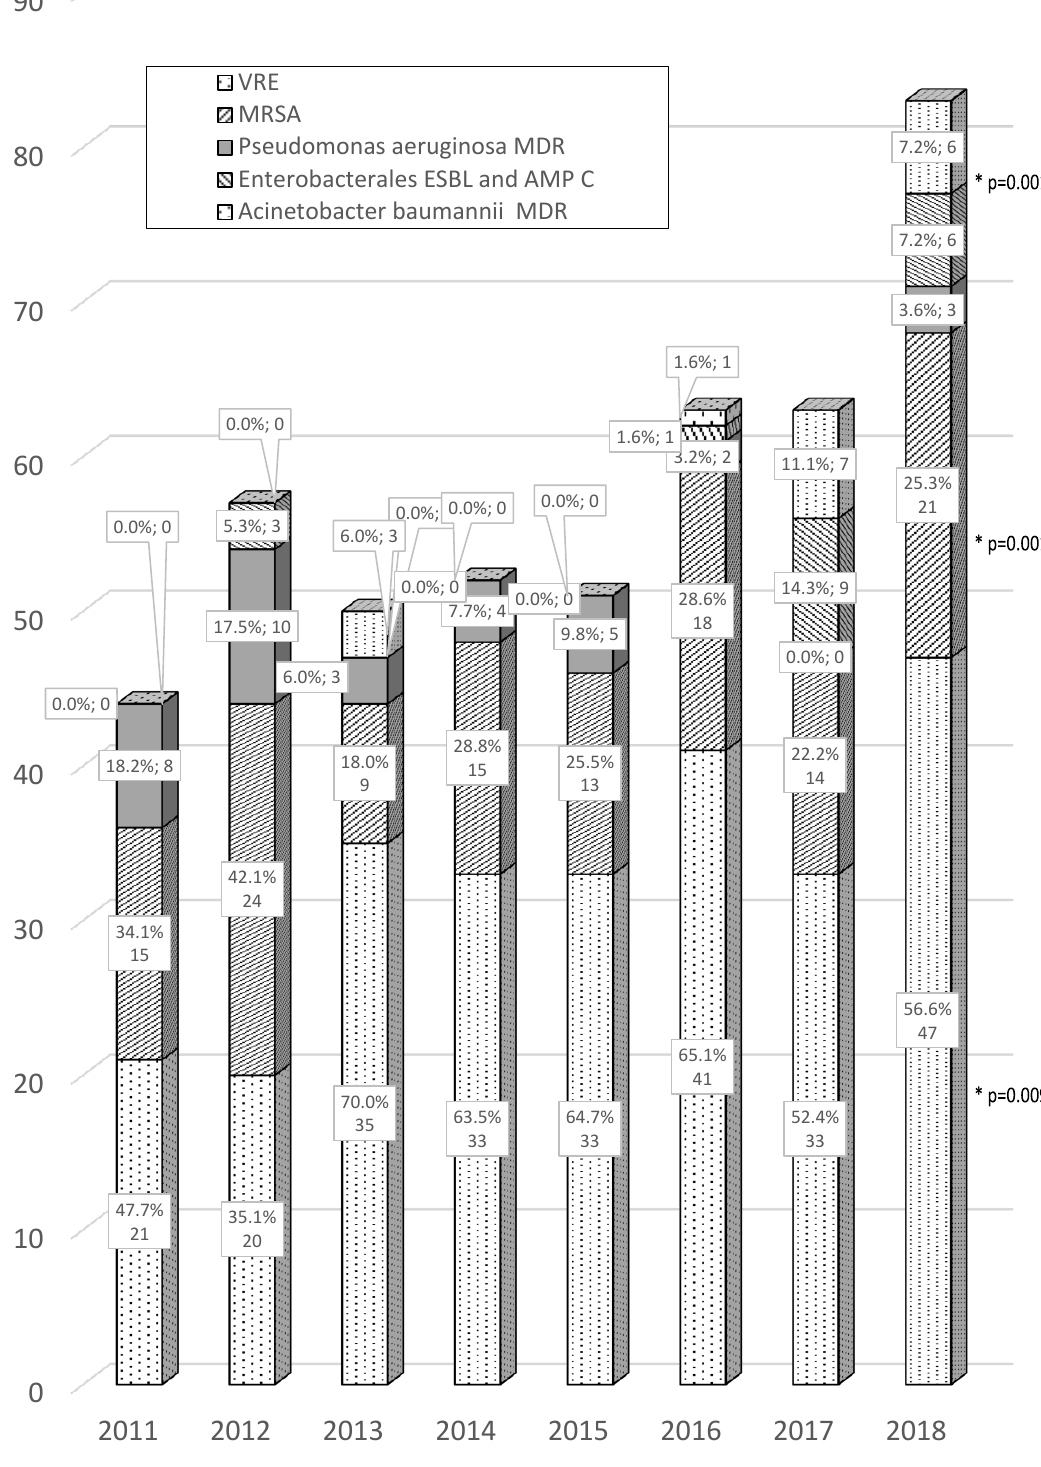
Figure 1. Alert pathogens isolated from hospital-acquired infections in the years 2011–2018. The data were presented as numerical values and percentage values of the total number of multidrug-resistant (MDR) strains in subsequent years. Legend: * p was calculated for comparison of the year 2011 vs. 2018. Only significant increase was